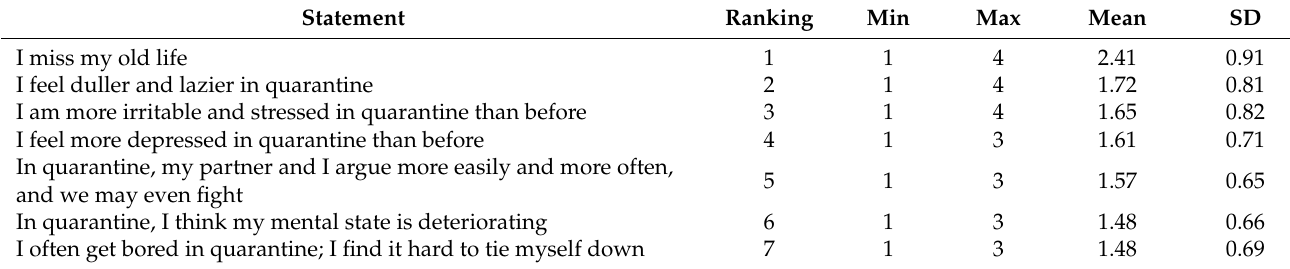
Table 3. Emotional and mental characteristics in quarantine (N = 46).